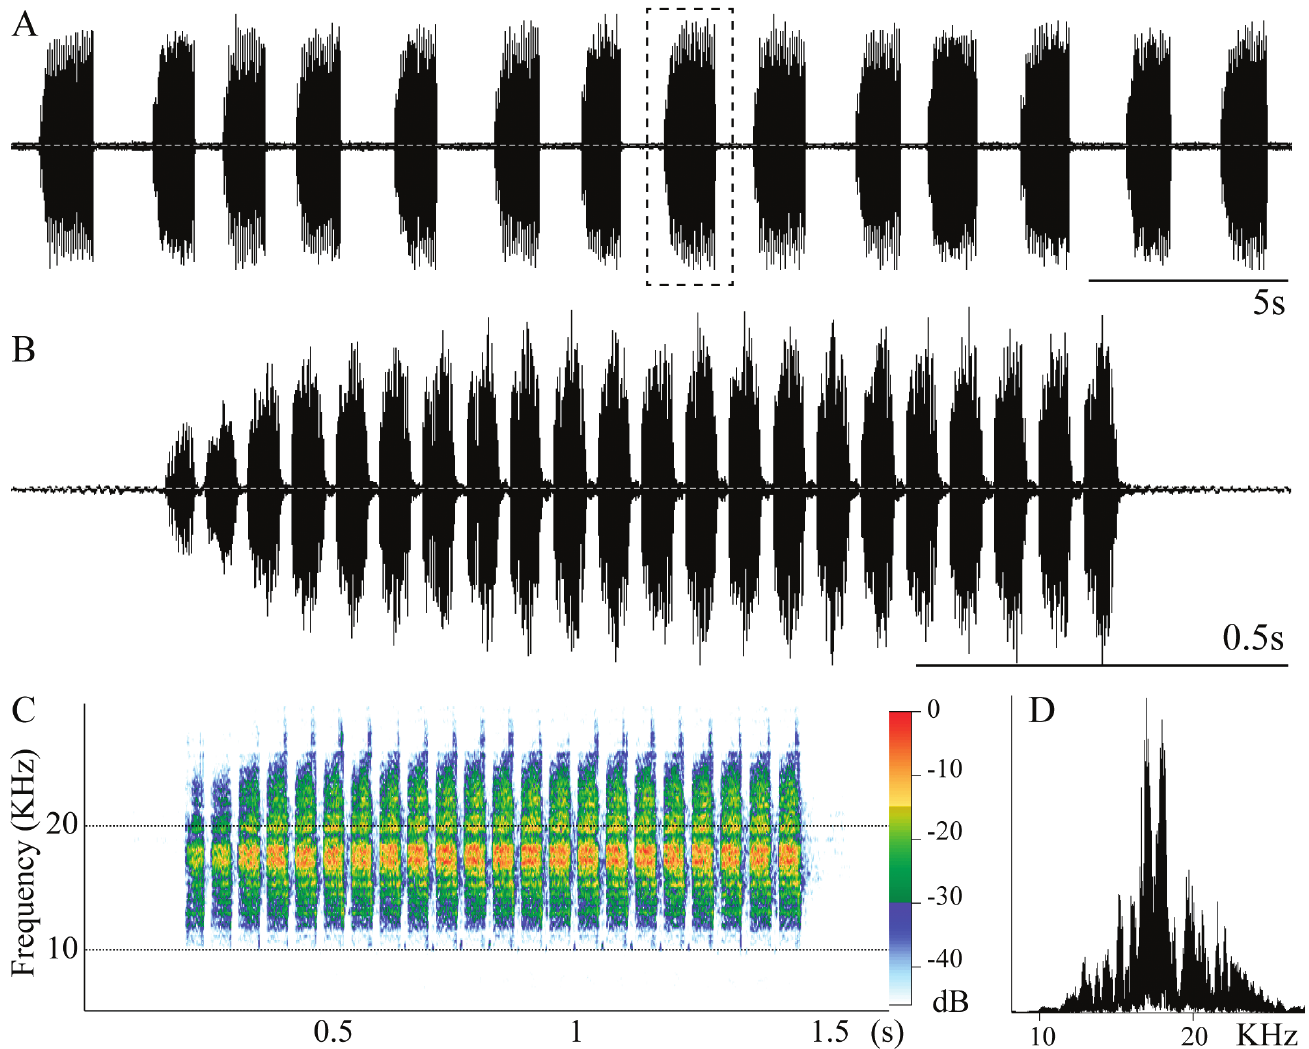
Fig. 7. Calling song of Toledopizia salesopolensis . A. Sonogram of an echeme sequence; B. sonogram of one echeme; C. 2-D spectrogram, ranging from 5 to 30 kHz, of one echeme; D. spectrogram of an echeme sequence, in linear intensity scale. produced into two acute lobes, the male cercus has a medial finger- like projection and a ventral mediodistal fold, the male subgenital plate has the hind margin with a V-like sinus and a conspicuous medial keel, and the female subgenital plate has the hind margin with a U-like sinus flanked by two small posterior projections;